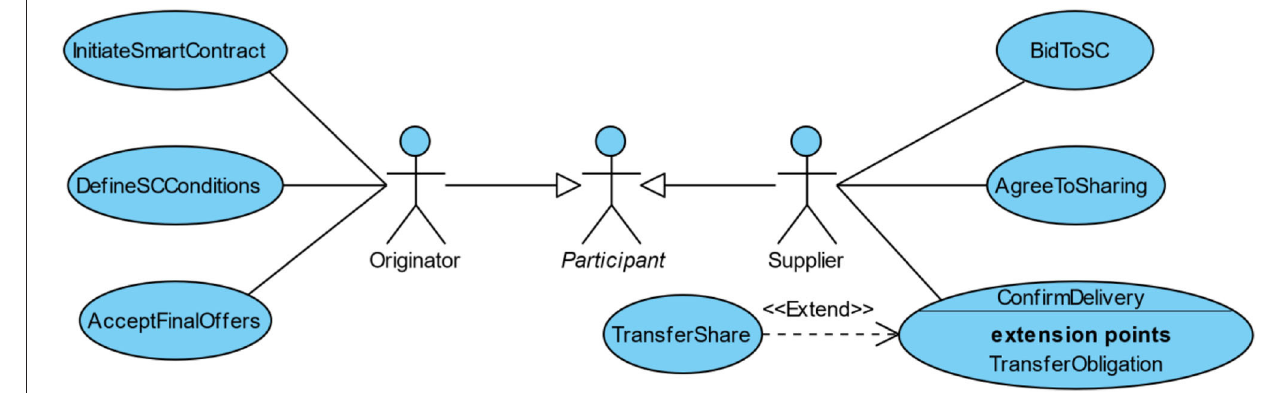
FIGURE 6 | Use cases for originator and supplier.